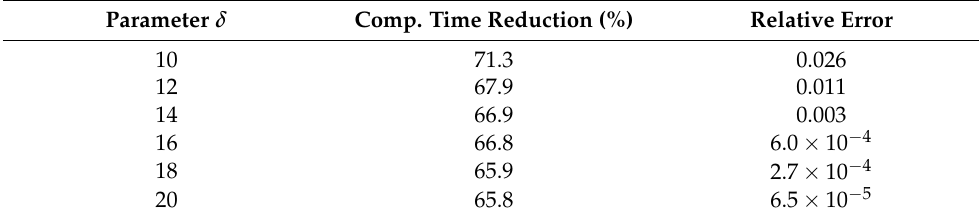
Figure 4. ( a ) The velocity model from [22]. ( b ) The map of relevant grid points in the final subinterval. ( c ) The wavefield at the final subinterval of the simulation. The parameter δ was set to 12. Table 2. Performance indicators for the third model.